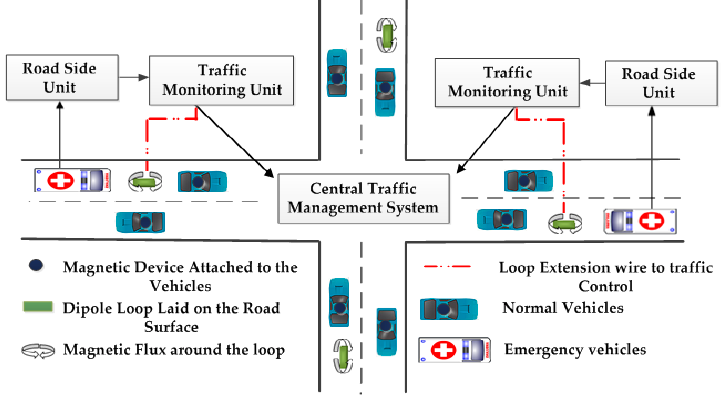
Figure 10. Layout architecture for efficient dynamic traffic control system [55].